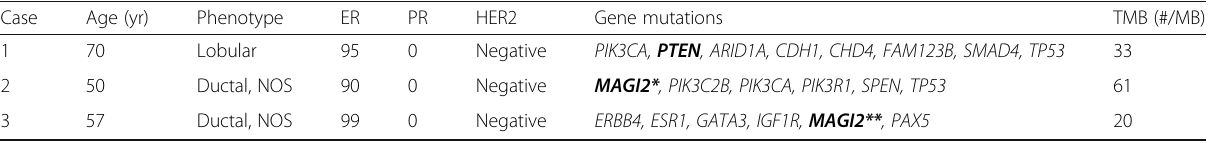
Table 4 Three breast carcinoma cases with high TMB